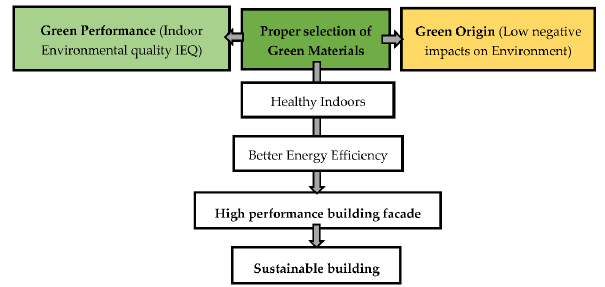
Figure 1. Flow chart of the research concept.